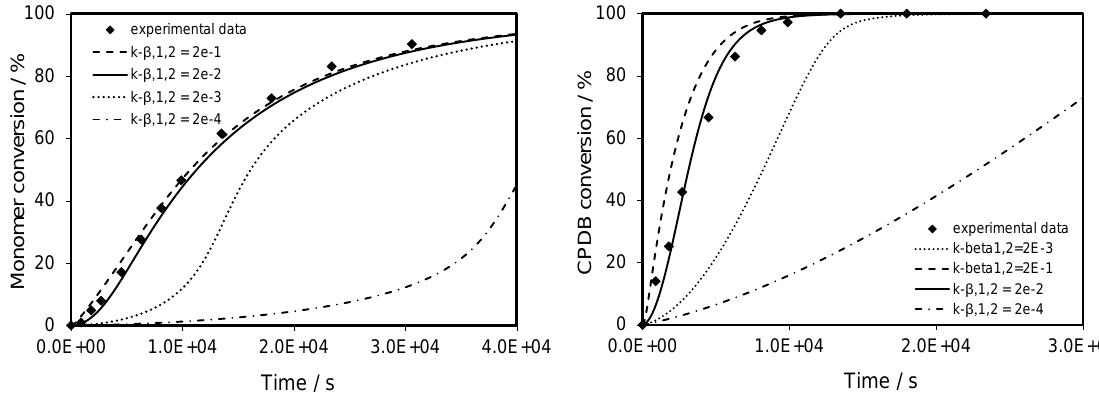
Figure 5. Evolution of monomer and CPDB conversion versus reaction time for CPDB-mediated polymerization of TBDMSMA in toluene at 70 °C with initial concentration of CPDB of 3.0 × 10 −2 mol·L −1 . The graph compares predicted values (lines) with experimental data (points).